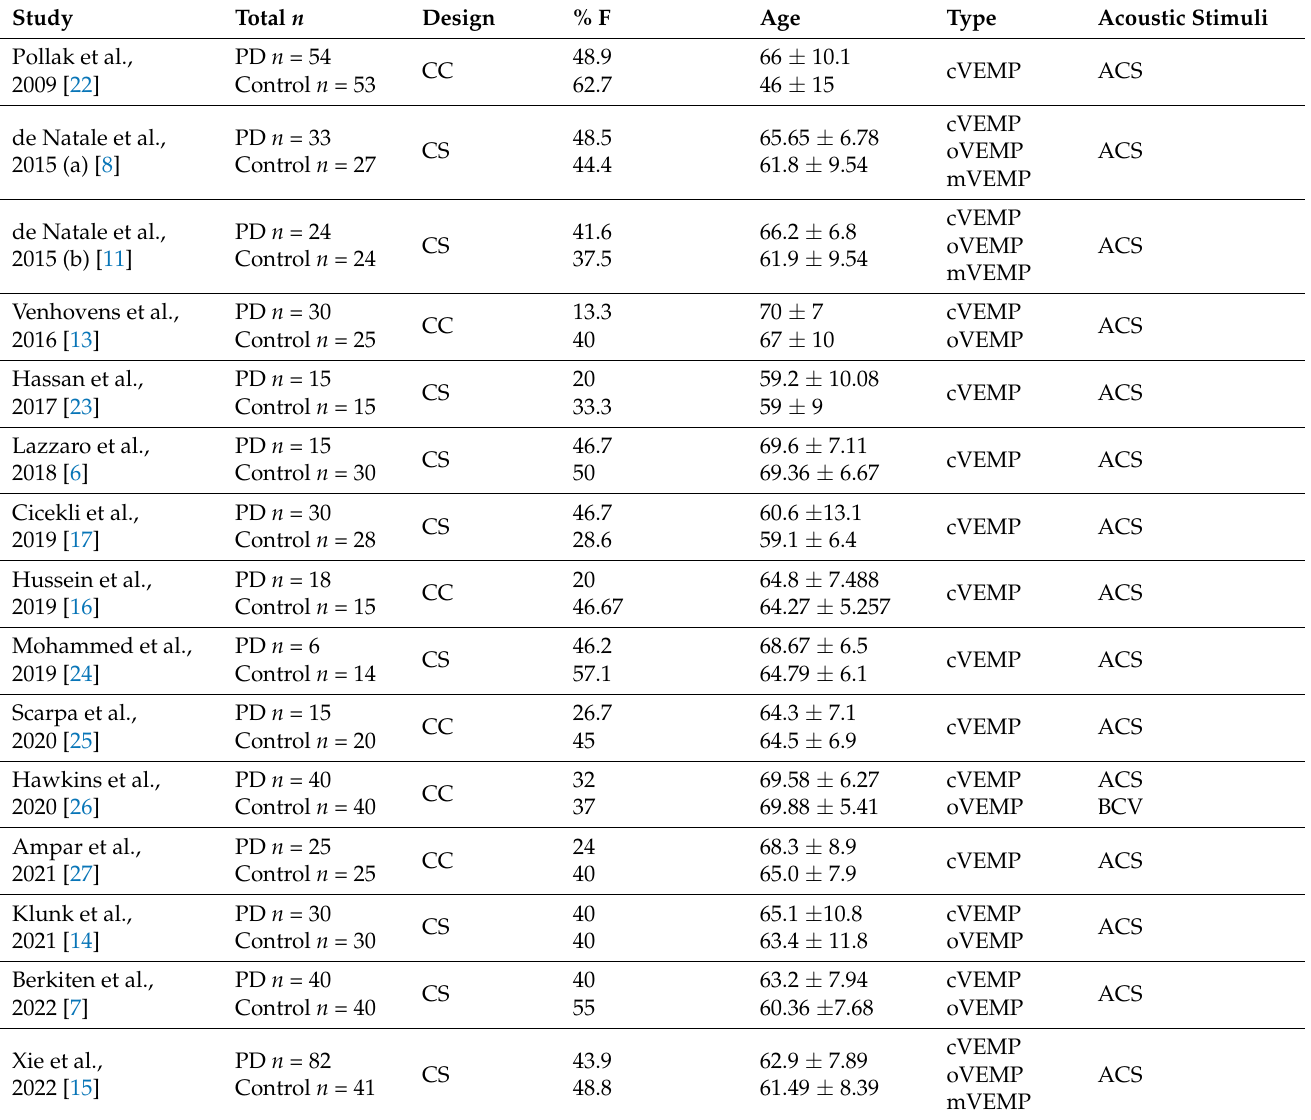
Table 1. Extracted and summarized details on subjects, methods, and measurements of the included